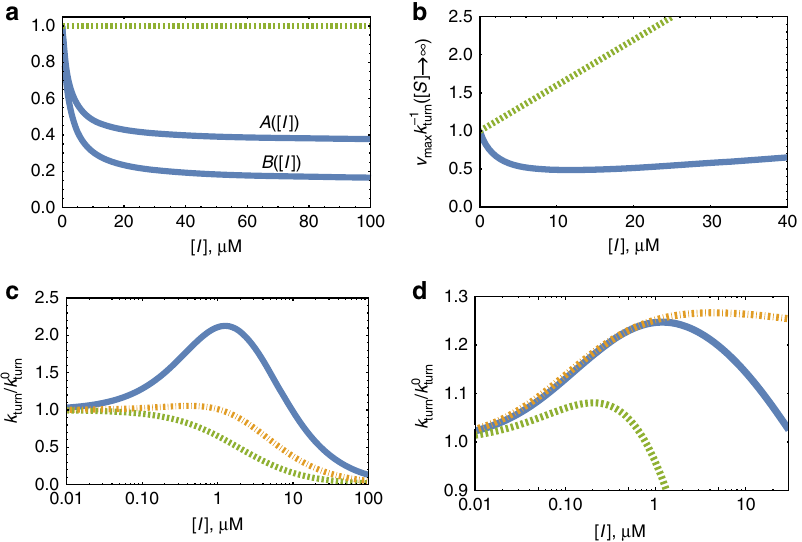
Fig. 5 Breakdown of the classical theory for uncompetitive inhibition. a In solid blue, A I ½ (cid:2)ð Þ and B I ½ (cid:2)ð Þ from Eq. (3) for the two-state model (main text). Here, p ¼ 0 : 1 ; k 1 ð Þ ¼ 50 ms (cid:4) 1 , k 2 ð Þ ¼ 0 : 5 ms (cid:4) 1 , and all other reaction times are taken from exponential distributions with k ¼ 2 : 3 ms (cid:4) 1 ; k ¼ 0 : 1 μ Mms ð Þ (cid:4) 1 , off on cat cat ¼ 3 μ Mms ð Þ (cid:4) 1 . The observed behavior should be compared to that obtained for k 1 ð Þ ¼ k 2 ð Þ and k ESI (dashed green line). The latter case coincides with the cat cat on from Eq. (3) vs. [ I ] in the classical reaction scheme in Fig. 1 (middle), and gives A I ½ (cid:2)ð Þ ¼ B I ½ (cid:2)ð Þ ¼ 1 for all [ I ]. b The normalized inverse turnover rate v max k (cid:4) 1 turn ¼ k 2 ð Þ limit of saturating substrate concentration. As in a , the dashed green line is drawn for the degenerate case k 1 ð Þ , where B I ½ (cid:2)ð Þ ¼ 1, and a linear behavior cat cat should (and is) observed. In contrast, the solid blue line is drawn for the two-state model with parameters as in a , and one could clearly observe strong deviations from linearity. This characteristic signature of non-Markovian kinetics is directly measurable. c The turnover rate (normalized by its value in the ¼ k 2 ð Þ ¼ 0 : 1 ms (cid:4) 1 (dashed green); (ii) k 1 ð Þ ¼ 10 ms (cid:4) 1 , absence of inhibition) vs. [ I ] for the two-state model with three different sets of parameters: (i) k 1 ð Þ cat cat cat k 2 ð Þ ¼ 0 : 5 ms (cid:4) 1 (dash-dot orange); and (iii) k 1 ð Þ ¼ 10 ms (cid:4) 1 , k 2 ð Þ ¼ 0 : 1 ms (cid:4) 1 (solid blue). In all three cases, p = 0.1 and other parameters are speci fi ed in cat cat cat